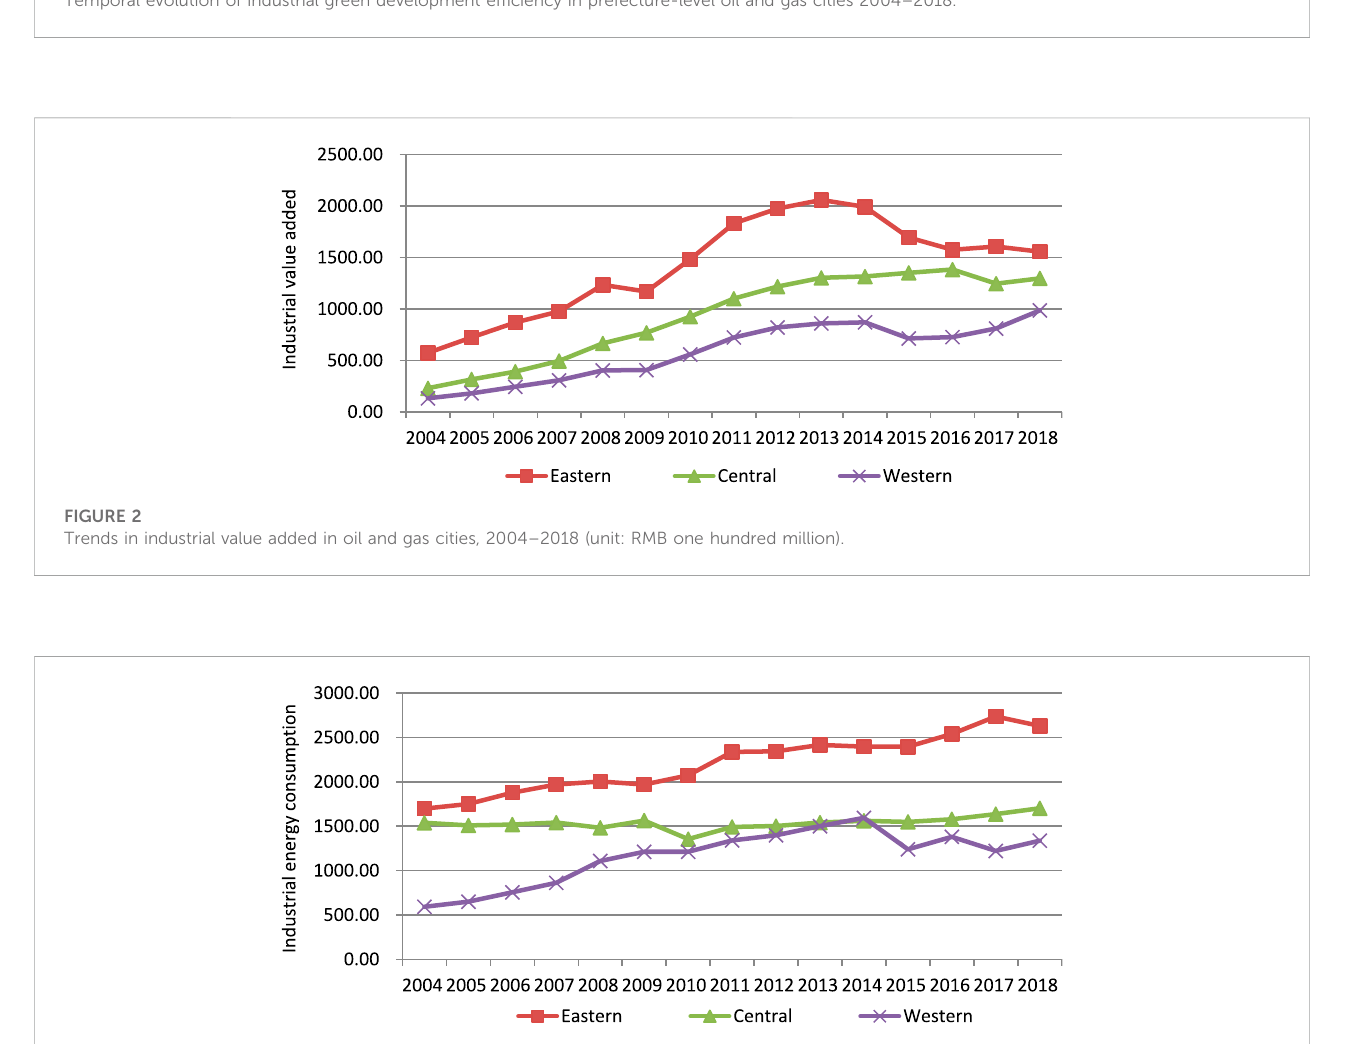
the western region is also signi fi cantly lower than that of the other two regions. Index is also signi fi cantly lower than the other two regions (Figure 4), so the ef fi ciency of industrial green development in the western region is signi fi cantly higher than that in the central